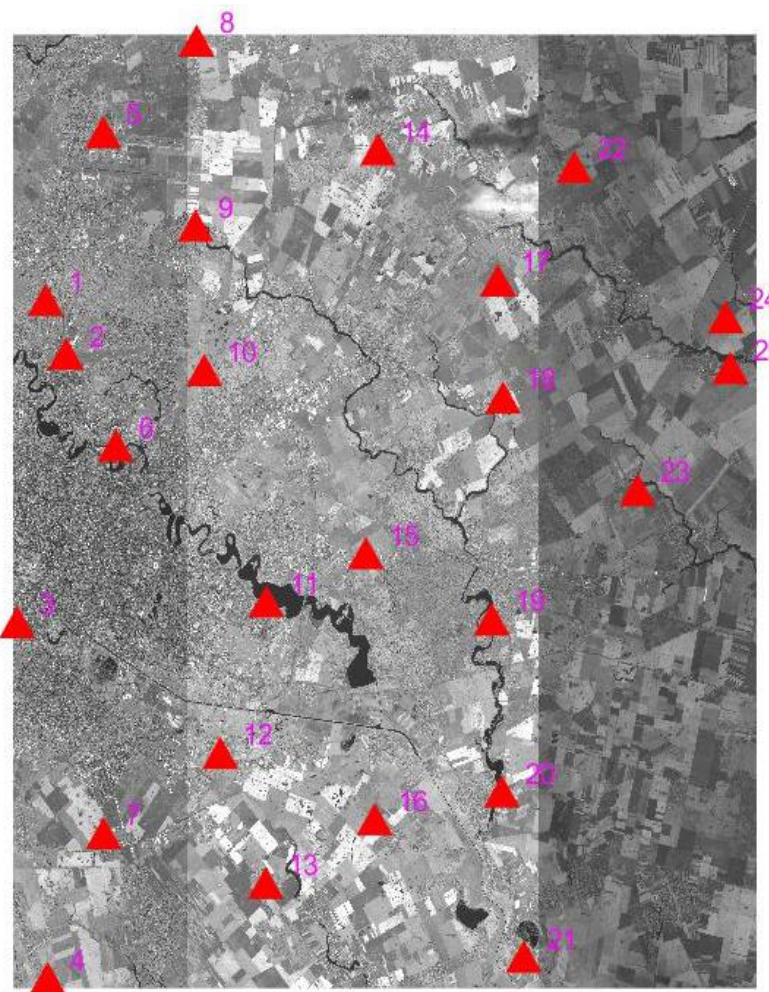
Figure 12. GCP distribution with the number.